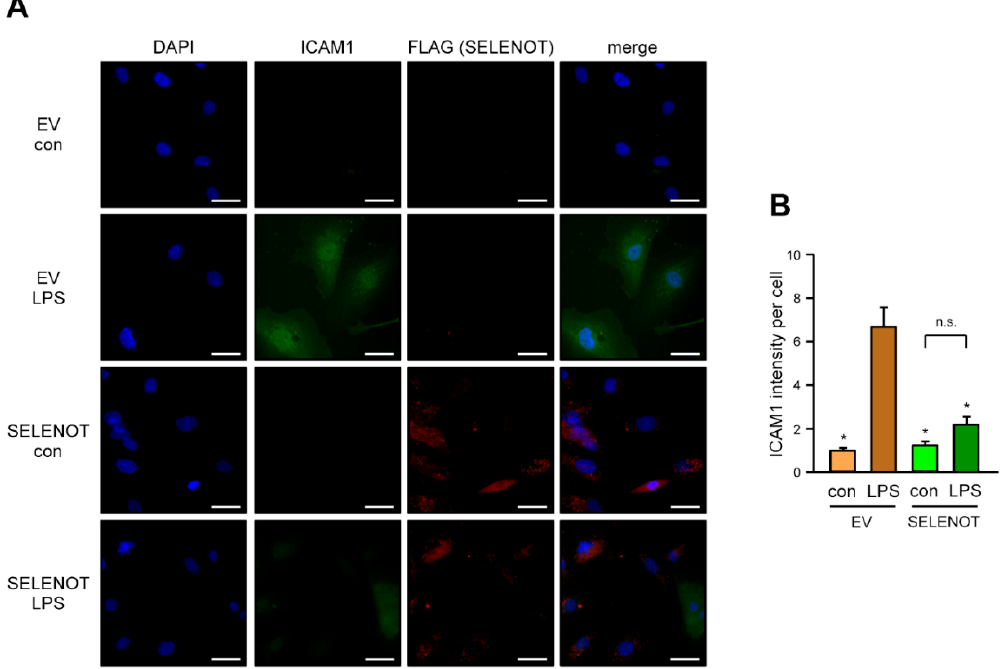
Figure 4. SELENOT suppresses LPS-induced upregulation of ICAM1. ( A , B ) EC were transfected with the FLAG-SELENOT expression vector (SELENOT) or an empty vector (EV) and treated with 150 ng/mL detoxified (con) or active LPS (LPS) for 18 h. FLAG-SELENOT and ICAM1 were detected by immunofluorescence. Cells were stained with an antibody directed ICAM1 (green) and an anti-FLAG antibody (red). Nuclei were counterstained with DAPI (blue); merge is the overlay of all channels. ( A ) Representative immunostaining (scale bar = 30 μ m). ( B ) Quantitation of ICAM1 levels. The intensity of the green fluorescence per cell was measured using Fiji; in the cells transfected with the SELENOT expression vector, only FLAG-SELENOT positive cells were included (data are mean ± SEM, n = 4, * p < 0.05 vs. EV/LPS, n.s. = not significant, one-way ANOVA with post-hoc Tukey LSD test).